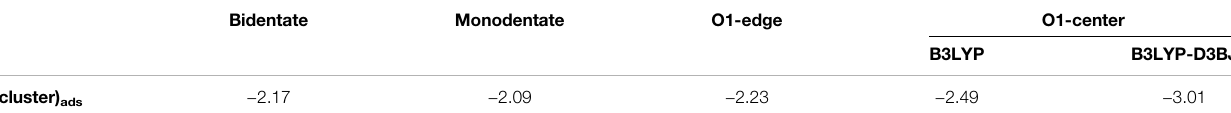
TABLE 1 | Adsorption energies of D -glucose, E (cluster) ads , on four different sites at the B3LYP level of theory. For the most favored O1-center mode, the B3LYP-D3BJ energy is also reported. Energies are given in eV.